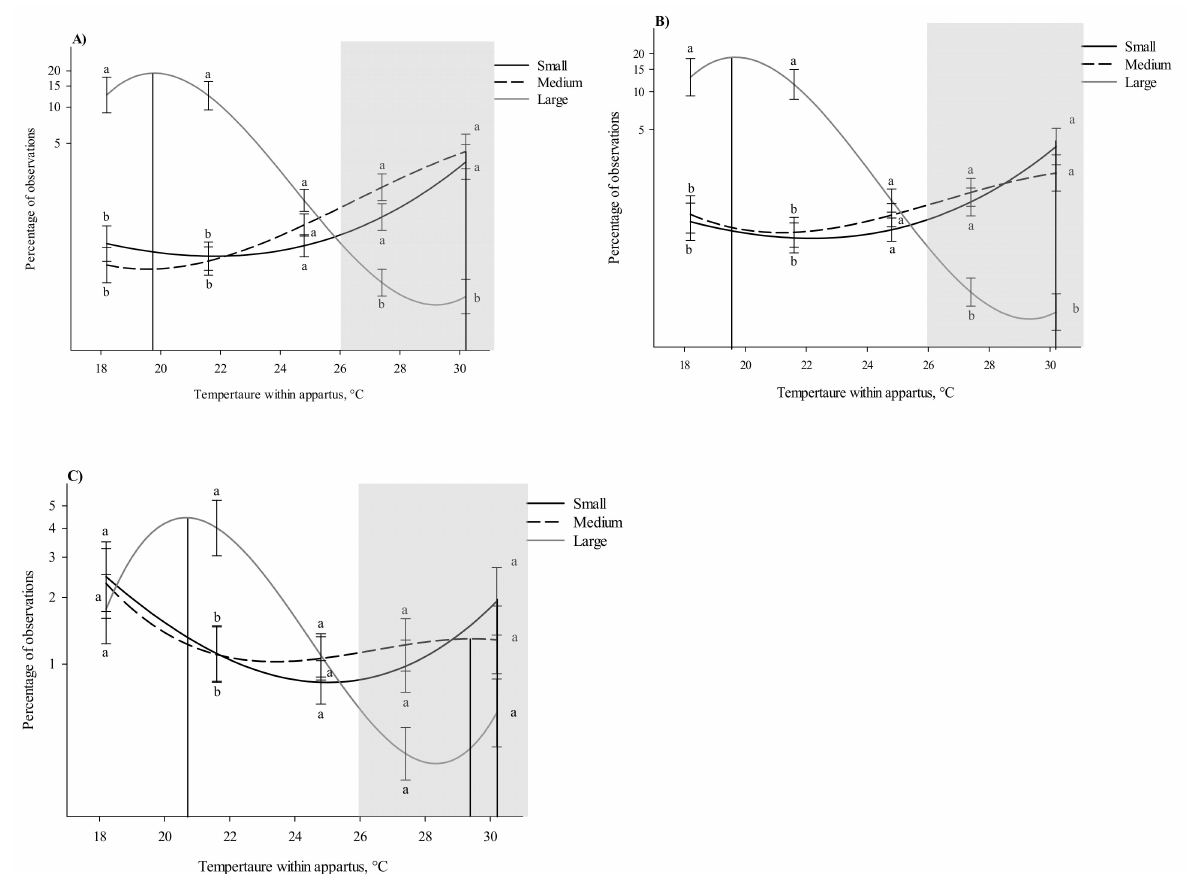
Figure 5. Percentage of observations in different temperatures within the thermal gradient while in different postures: ( A ) lateral laying ( B ) sternal laying and ( C ) upright. The effects of being tested by weight category: small (3–7 kg), medium (7.1–11 kg) and large (11.1–15 kg), on temperature preference based on posture. Temperature within the thermal apparatus is plotted on the x axis and percentage of time spent are plotted on the y axis as a log10 + 0.001 scale. Cubic peaks are indicated by vertical lines corresponding to group weight category within posture. Standard error bars are located at the temperatures of the five thermal zones (18.2, 21.5, 24.8, 27.3, and 30.3 ◦ C) and different letters denote significant Tukey pairwise comparisons ( p < 0.01). The gray box indicates the recommended temperatures (26 to 32 ◦ C) for pigs between 3 and 15 kg [12]. Equations for the curves shown above can be found in Figure